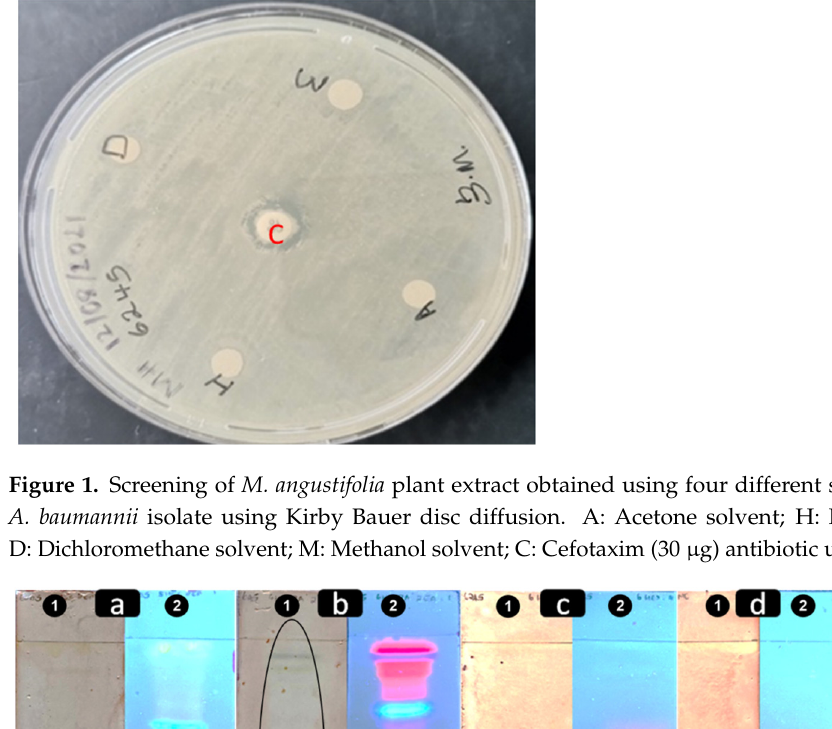
Table 1. Antibacterial activities of plant extract against A. baumannii .